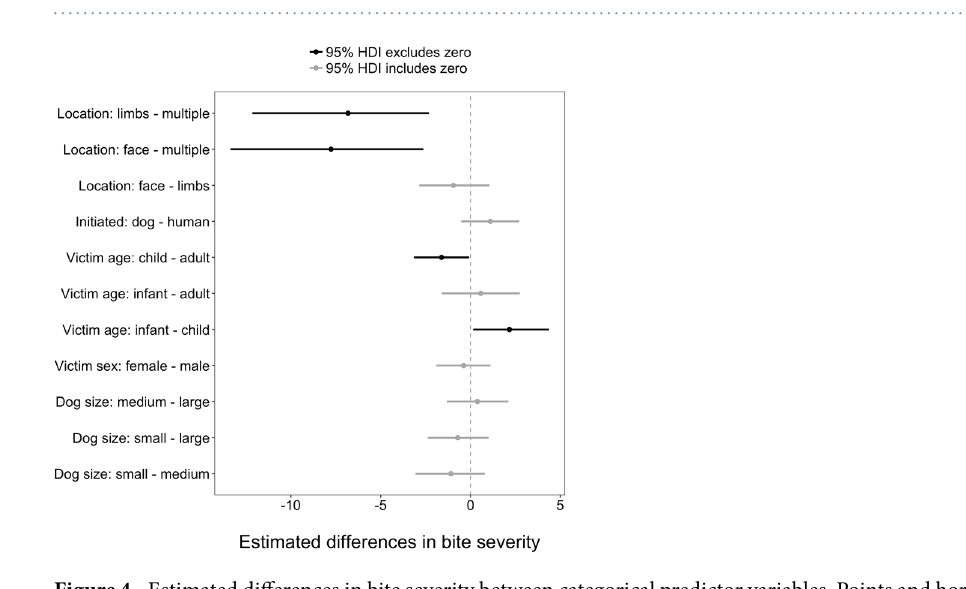
Figure 3. Estimated bite severity in each context. Black points and lines represent the regression model mean and 95% HDI estimates. Blue points and lines represent the raw sample means and bootstrap 95% CIs. Sample sizes are shown next to each parameter. Regression model estimates are pooled towards the overall mean (dashed vertical line) when contexts have relatively low sample size (e.g. resting) and/or deviate greatly from the overall mean without enough data to support such a difference (e.g. territorial).